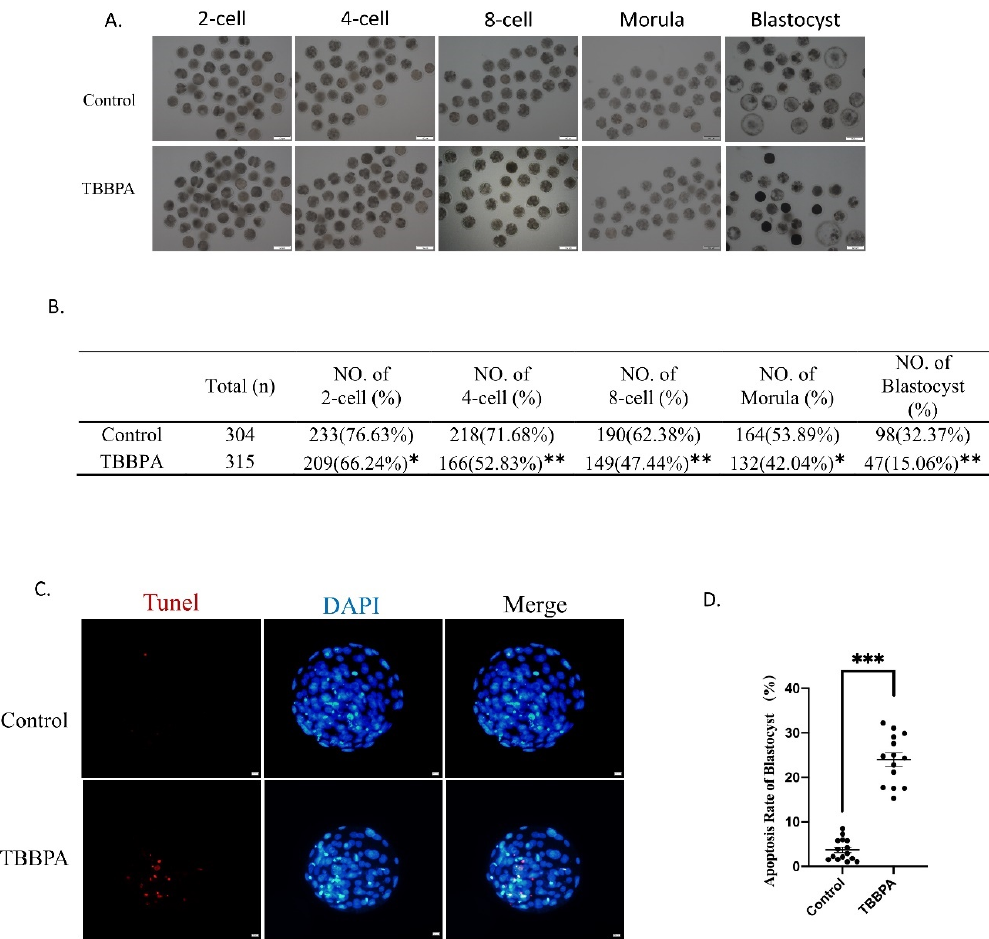
Figure 6. Effects of TBBPA on the developmental competence of oocytes: ( A ) Development of embryos in different stages after TBBPA treatment. Scale bar = 100 µ m. ( B ) Developmental percentage of embryos in different stages. ( C ) Representative images of TUNEL staining of blastocysts in control and TBBPA groups. Ex/Em, 529/590; Ex/Em, 371/464 nm. Scale bar = 10 µ m. ( D ) Apoptotic rate of blastocysts in each group. * p < 0.05, ** p < 0.01.***, and p < 0.001.